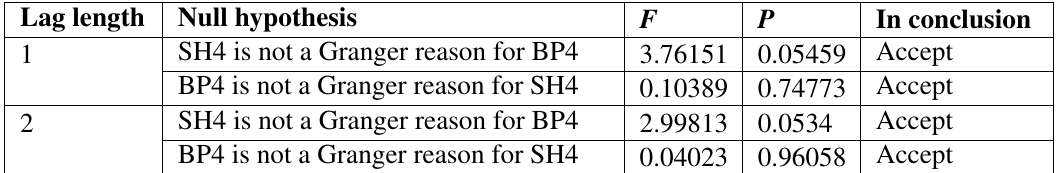
Table 4 SH4 and BP4Granger causality